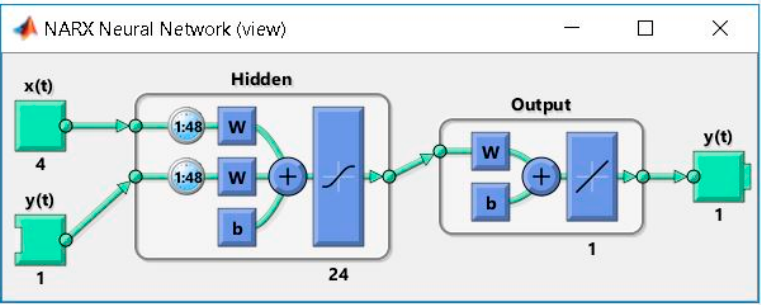
Figure 14. The ANN_NARX_BR_TS’s architecture.